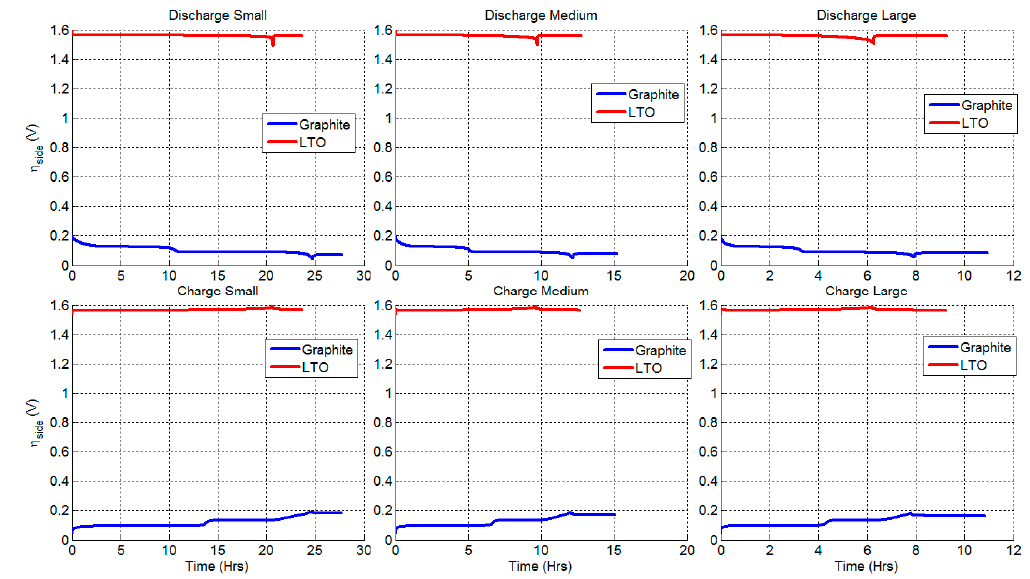
Figure 9. Activation overpotential of side reactions in graphite and LTO half-cells cycled at 0.045 C, 0.089 C, and 0.13 C.